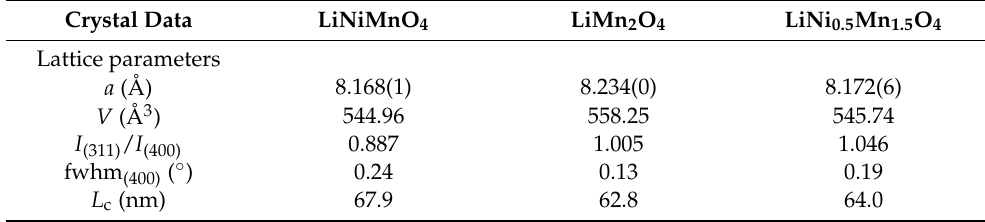
Table 1. Results of the Rietveld refinements for Ni-rich LiNiMnO 4 and its parent LiMn 2 O 4